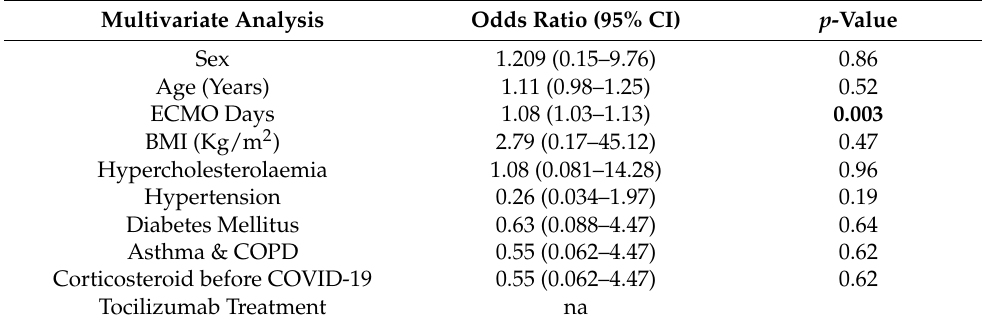
Table 4. Risk factors for CAPA during ECMO treatment in multivariate analysis.